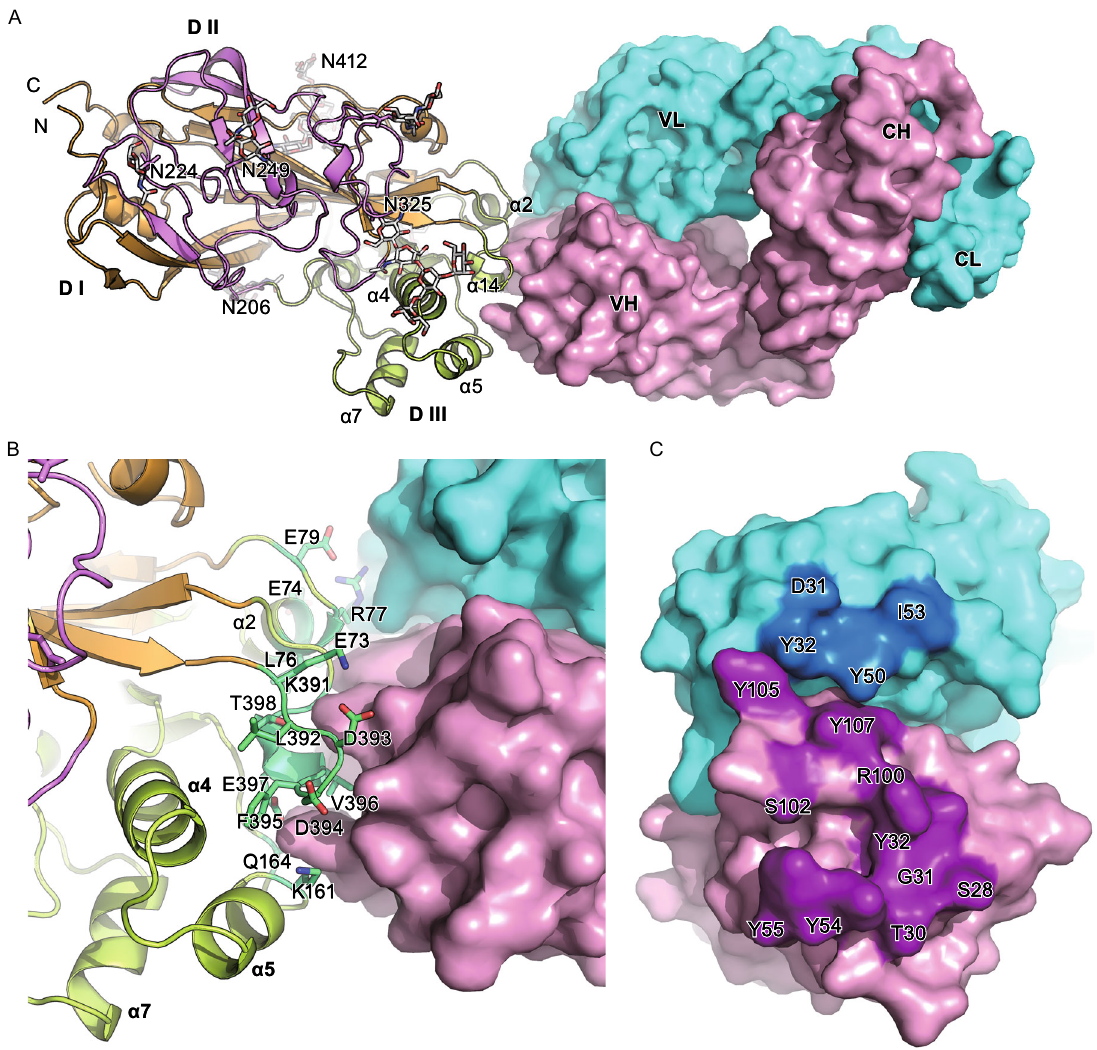
Figure 4. The complex structure of JL2 Fab bound to SCARB2 (at pH 7.0). (A) The overall complex structure. The JL2 Fab binds to the head of SCARB2 (Domain III) at a perpendicular angle with helices α 2, α 5, and α 14 involved in the interaction. Domain I, II, and III of SCARB2 are colored in orange, violet and yellow, respectively. Glycans are shown as sticks. (B and C) Cartoon representation of the interacting residues in SCARB2 (B) and Fab (C). The residues in SCARB2 involved in the interactions with JL2 Fab are shown as sticks (B). The residues in JL2 Fab involved in the interactions with SCARB2 are highlighted in bright colors and labeled on the surface